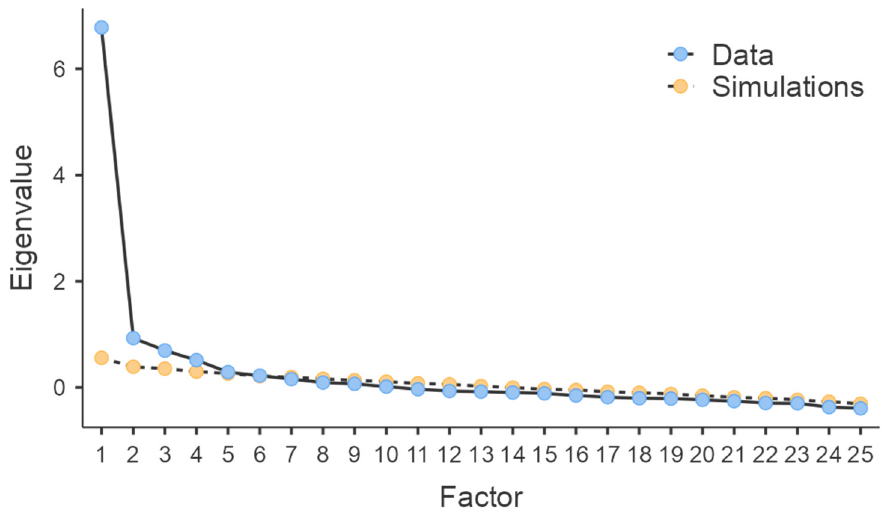
Figure 2. Scree plot of EFA.